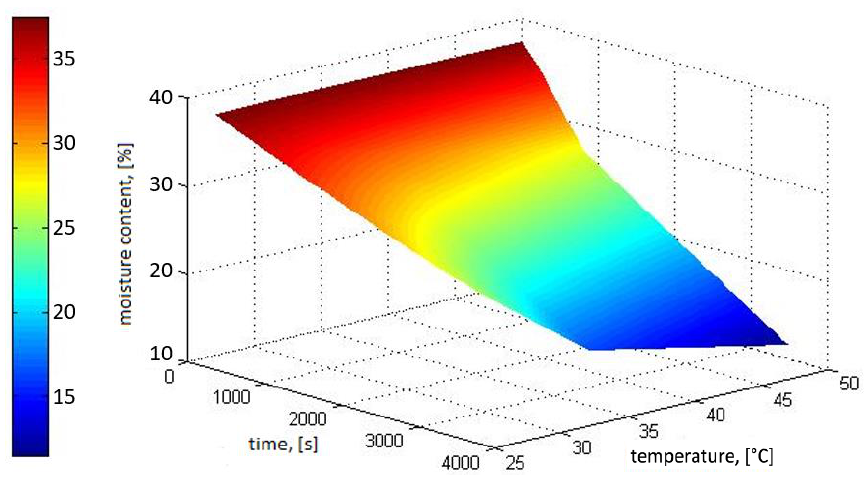
Figure 16. Plane diagram of the drying process, 2D installation; Turów; 0-8 mm; temperature: 27–50 °C.